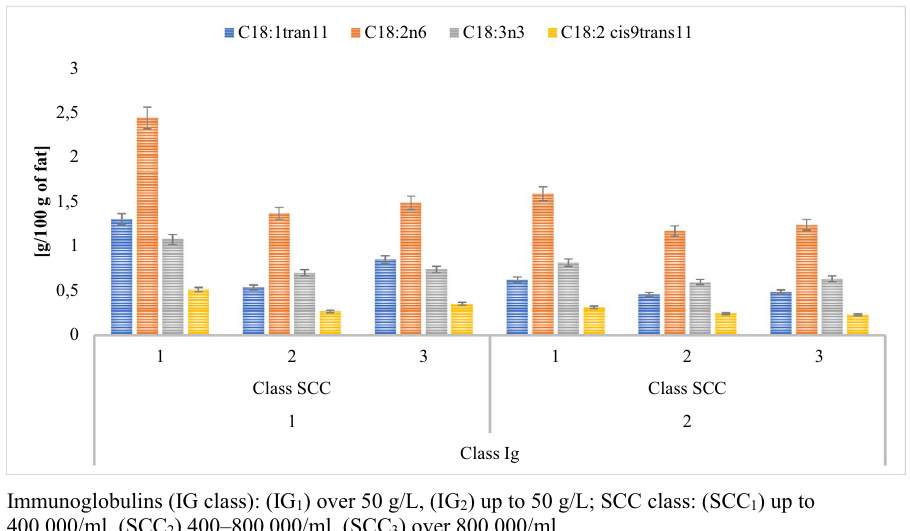
Figure 6. Interaction between the level of immunoglobulins and SCC as a factor influencing the level of selected fatty